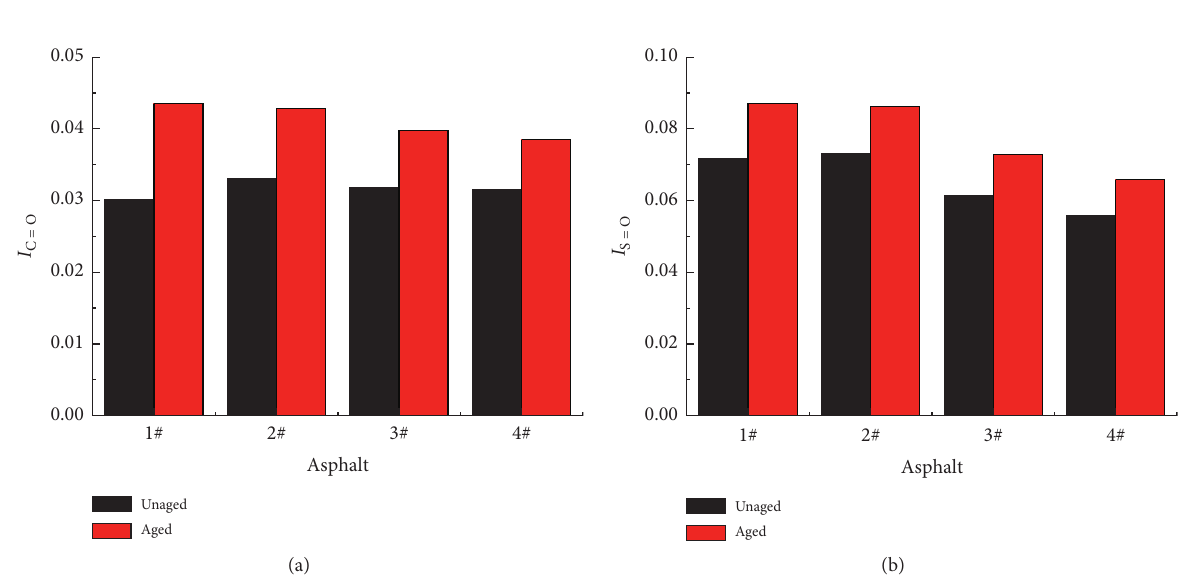
Figure 9: The Characteristic functional groups index of asphalt before and after UV ageing. (a) The carbonyl group index ( I sulfoxide group index ( I S � O